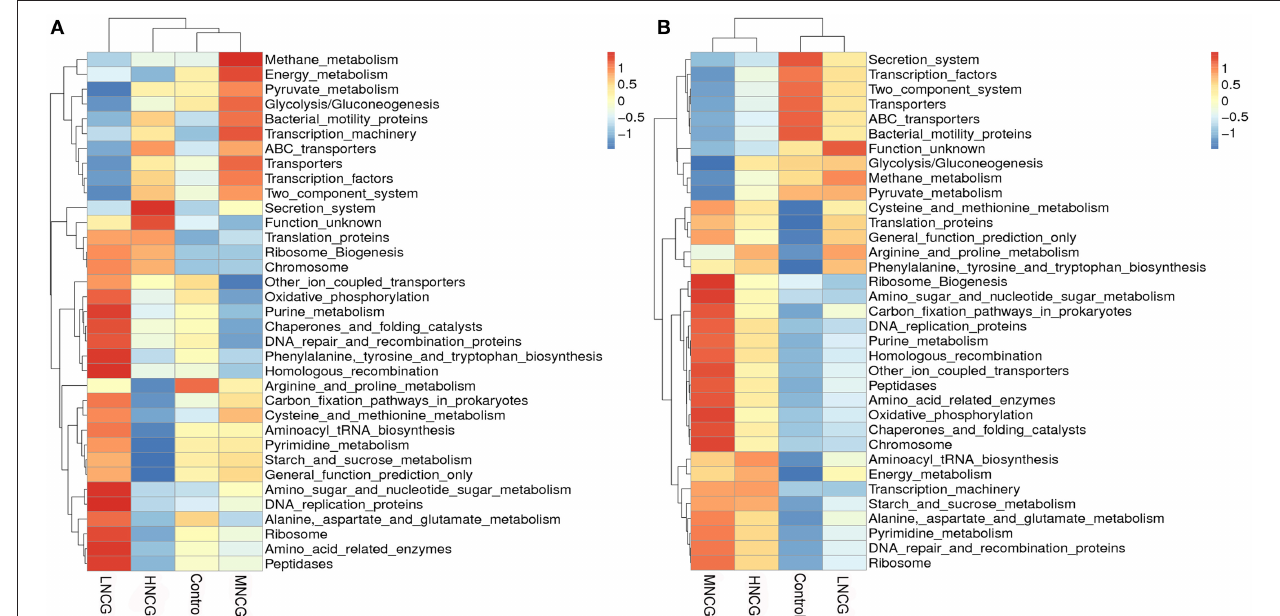
FIGURE 2 | Heatmap of bacterial metabolic pathways obtained from PICRUSt analysis. NCG, N-carbamylglutamate; Control, without NCG supplementation; LNCG, NCG at 15 g/day per cow; MNCG, NCG at 20 g/day per cow; HNCG, NCG at 25 g/day per cow. PICRUSt analysis, Phylogenetic investigation of communities by reconstruction of unobserved states analysis. Microbiota functions in ruminal content (A) and feces (B) were analyzed by PICRUST. The ruminal and fecal microbiota function in NCG treatment groups were differed from those in the control that metabolism of energy, amino acid, pyruvate, glycolysis, and carbon fixation were enhanced in NCG